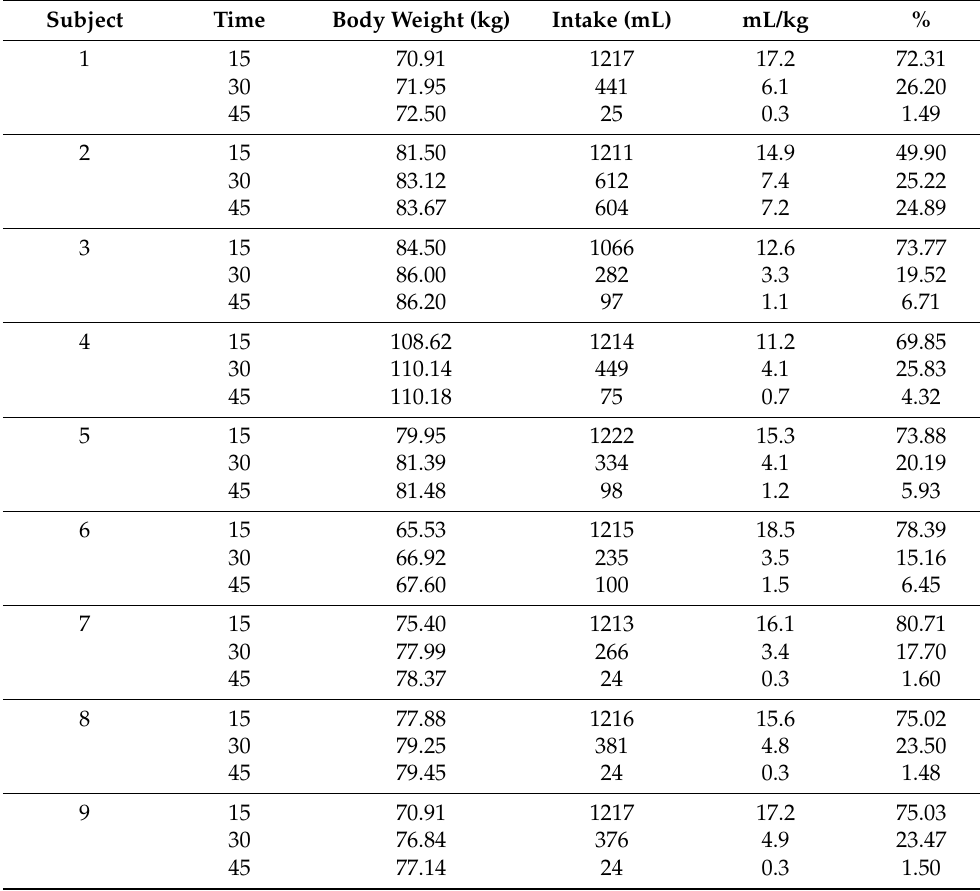
Figure 1. Voluntary water intake for each 15 min period. Bars represent average consumption and dots represent individual values of consumption. Only one participant did not interrupt rehydration at the 45 min point, but his intake from 45 to 60 min was negligible. Table 1. Individual percentage of total intake and mL/kg every 15 min.